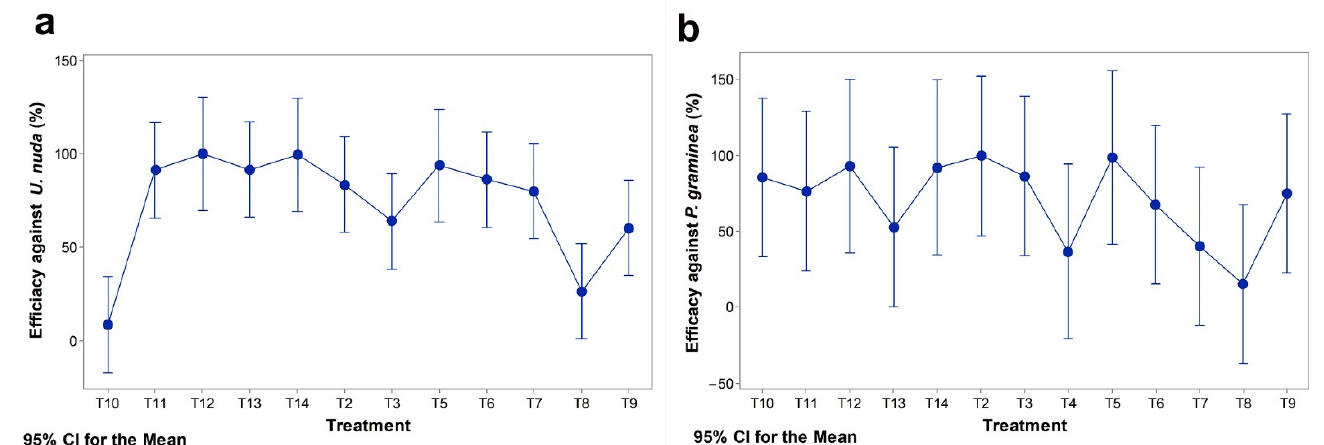
Figure 5. Fungicide efficacy against U. nuda ( a ) and P. graminea ( b ) in the period 2014–2020; T2- RAXIL S 040 FS; T3- VITAVAX 200 FF; T4-MANKOGAL S; T5-VIBRANCE DUO; T6- RANCONA